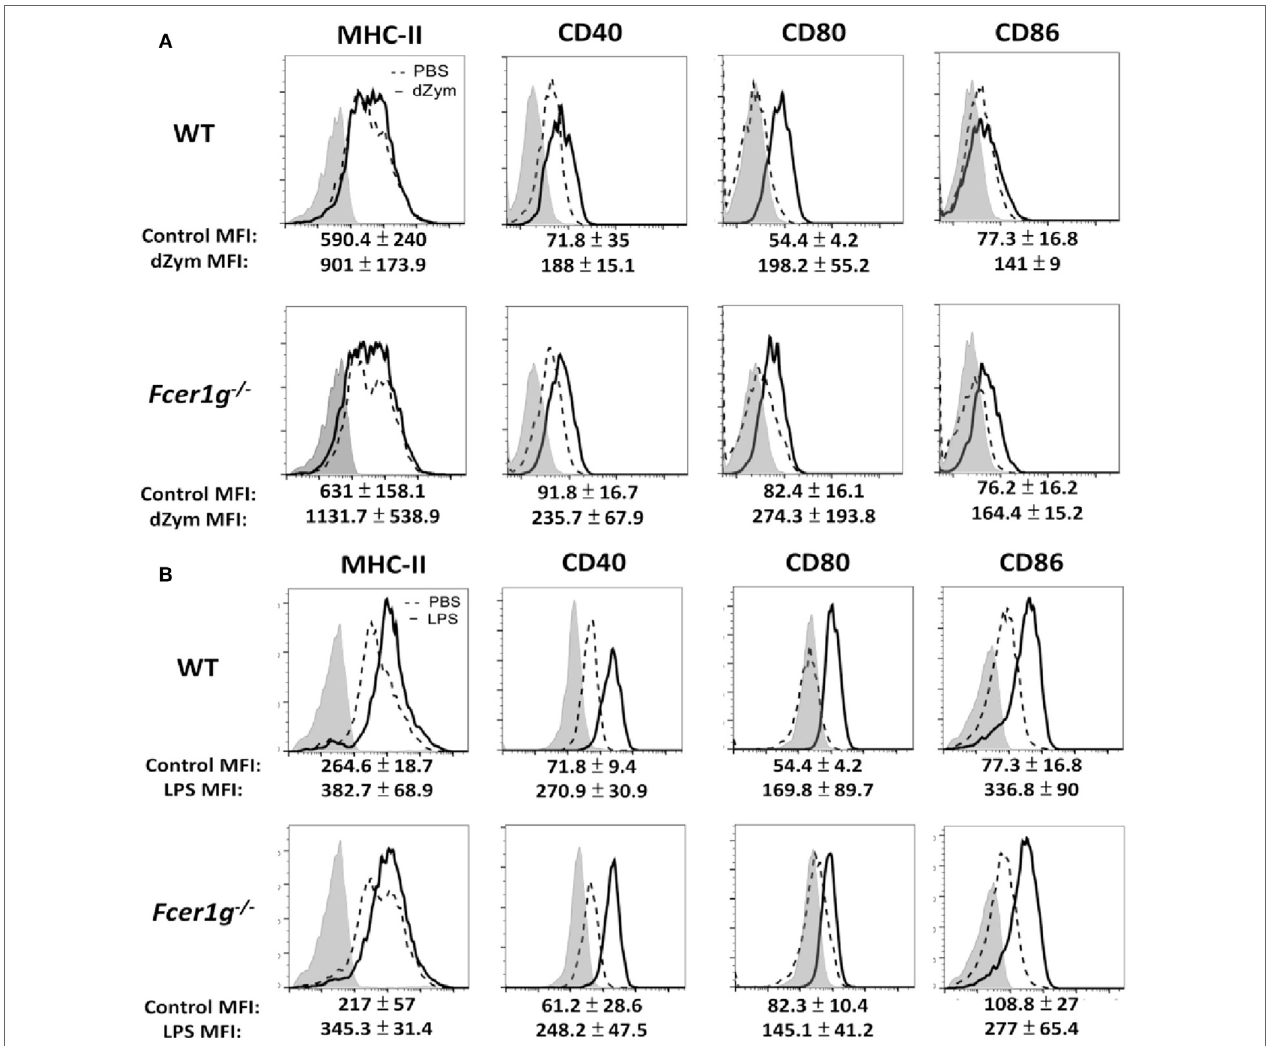
FigUre 4 | Loss of Fc ε RI γ -Chain did not affect the maturation of macrophages. Bone marrow-derived macrophages derived from WT and Fcer1g − / − mice were cultured for 6 days. Cells were then incubated with PBS (dash line), dZym (10 µg/mL, solid line) (a) , or LPS (100 ng/mL, solid line) (B) for 16 h. The expressions of MHC-II, CD40, CD80, and CD86 were analyzed by flow cytometry. The changes of MFIs (statistic from three independent experiments) from control to treatment were indicated under each histogram. Gray areas represented the isotype controls. All flow data shown are representative from three independent